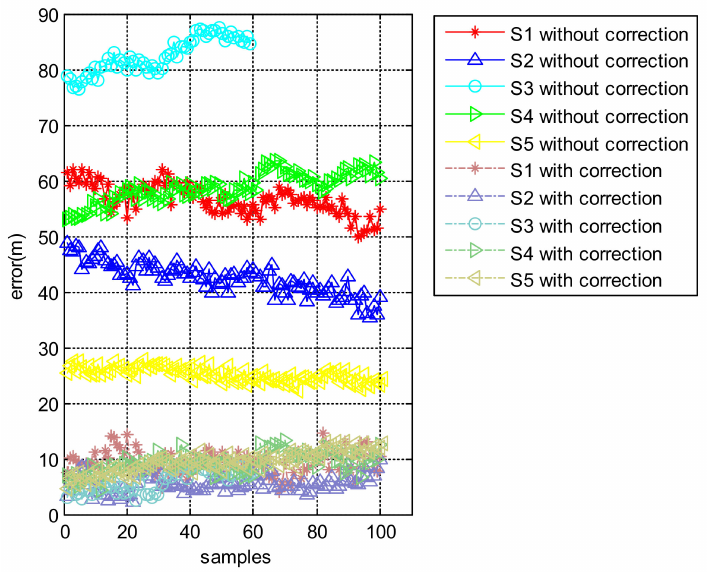
Figure 13. The computation results of the installing errors.